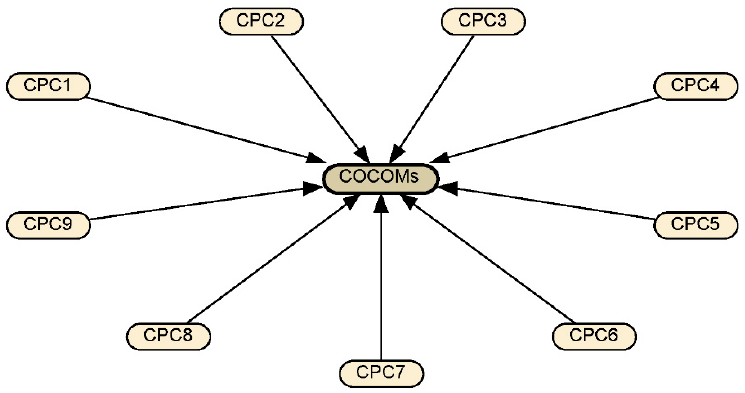
Figure 5. The BN model for the CREAM.